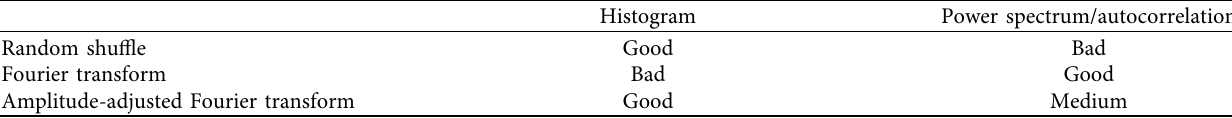
Figure 3: Correct decision rate (CDR) versus the autocorrelation coefficient at a time cycle of 1,000 for reward probability combinations of (a) P A � 0 . 4 ,P B � 0 . 5 and (b) P A � 0 . 8 ,P B � 0 . 9. Table 2: Properties of surrogate